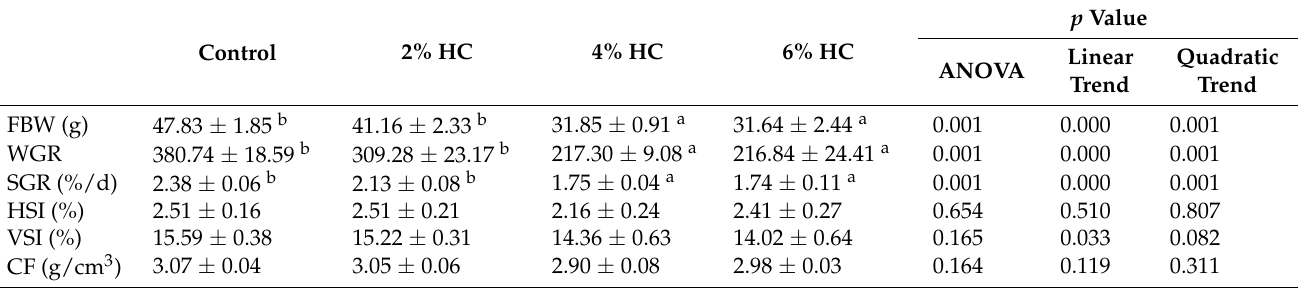
Table 6. Effects of hydrolyzed collagen replacing fish meal on growth and morphometric indexes of triploid crucian